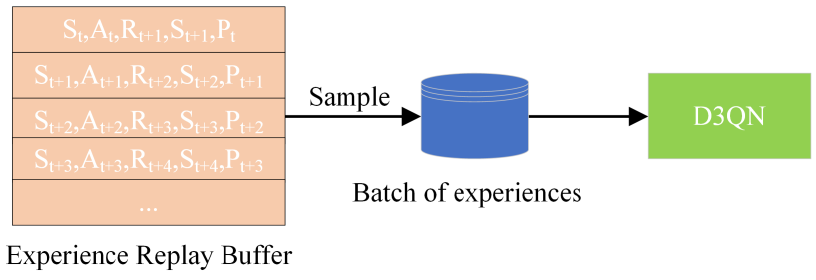
Figure 7. Schematic diagram of the empirical replay process.